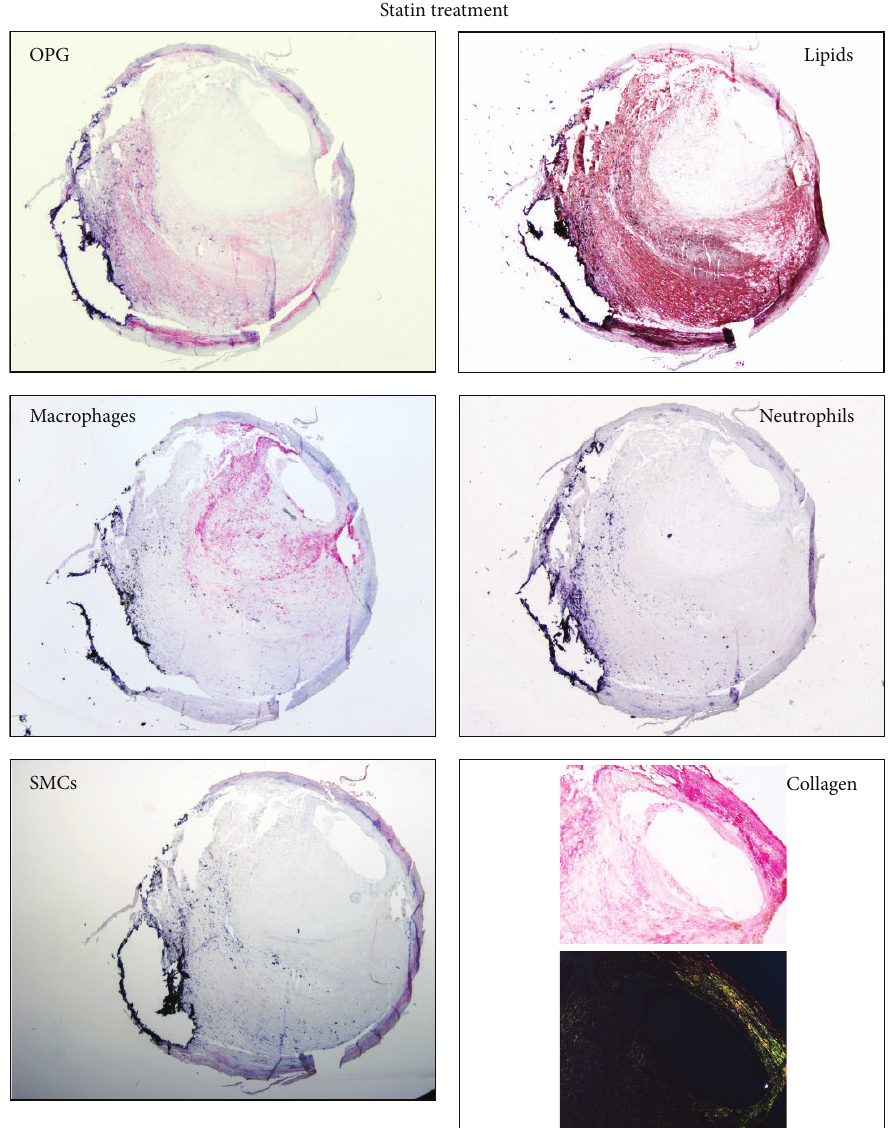
Figure 1: Representative microphotographs of consecutive cryosections from upstream regions of carotid plaques from patients on statin treatment. Staining for osteoprotegerin (OPG), lipids, macrophages, neutrophils and smooth muscle cells (SMCs), and collagen is